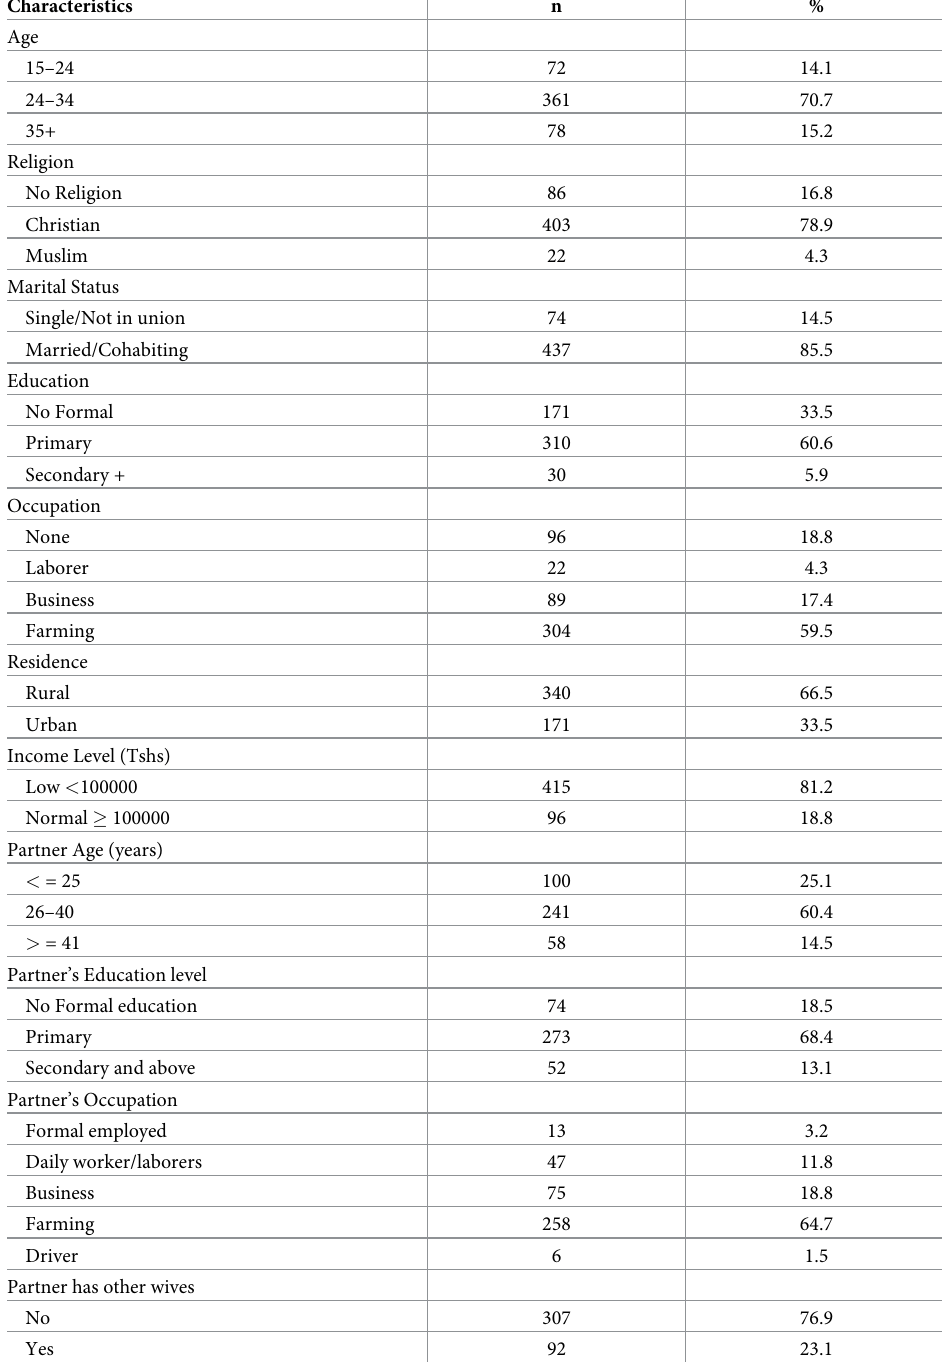
Table 1. Socio-demographic characteristics of the study participants (N =